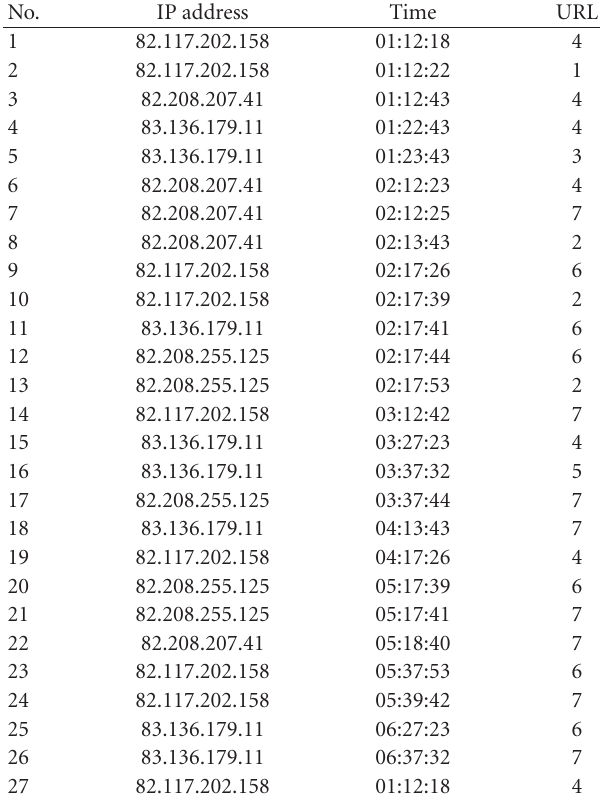
Table 1: Example data.